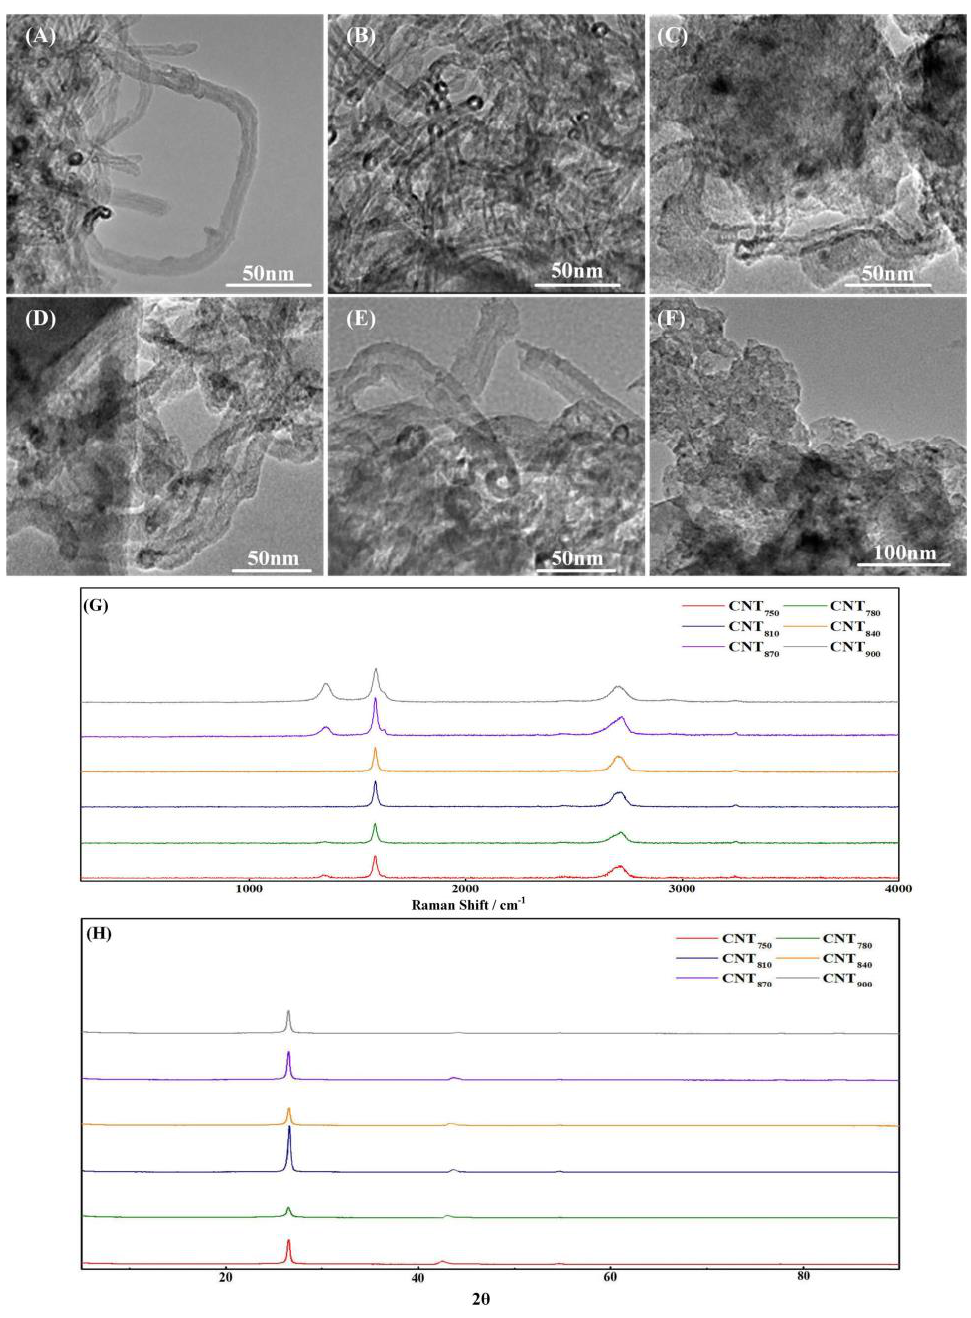
Figure 4. TEM images of MWCNTs prepared at different temperatures: ( A ) CNT750; ( B ) CNT780; ( C ) CNT810; ( D ) CNT840; ( E ) CNT870; ( F ) CNT900; ( G ) Raman spectra of MWCNTs prepared at different temperatures; ( H ) XRD of MWCNTs prepared at different temperatures.